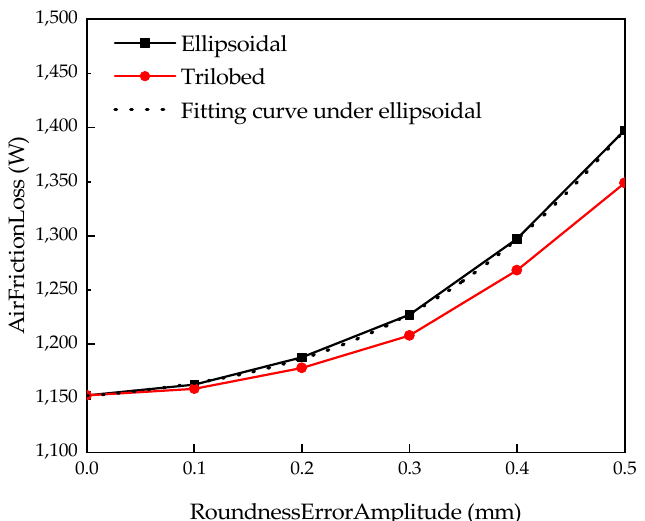
Figure 15. Calculation results of air friction loss at 36,000 r/min with different roundness error types.